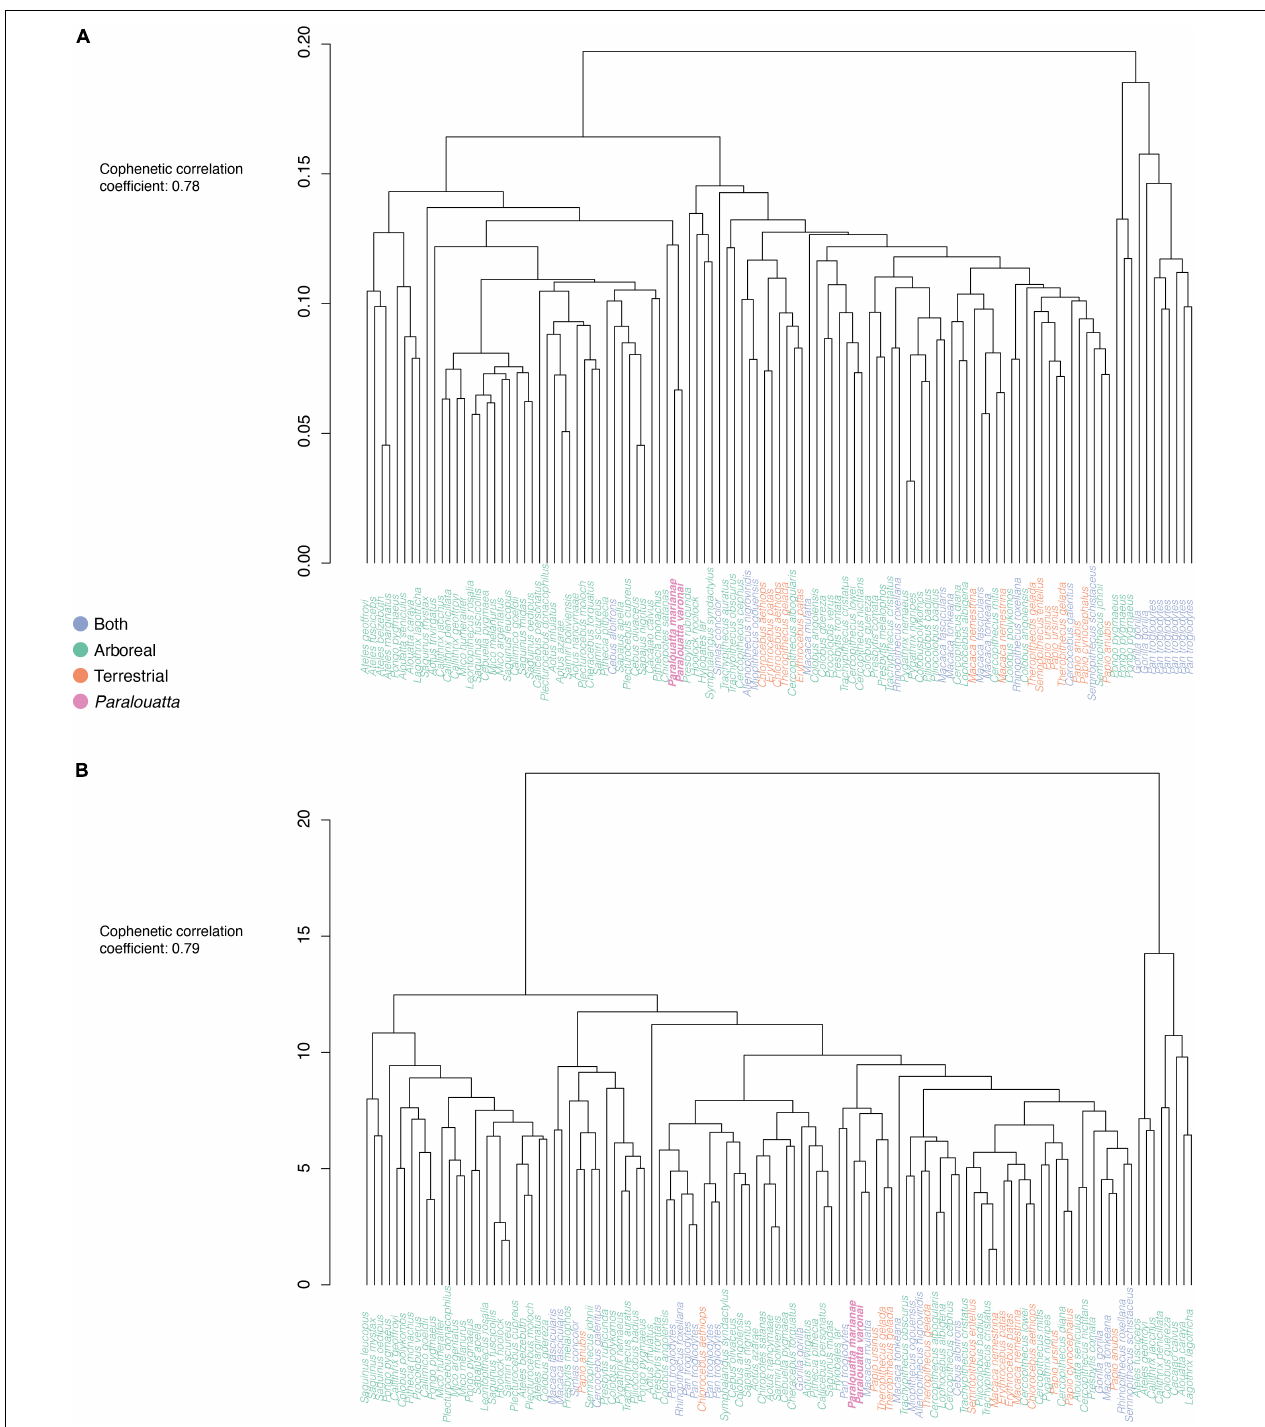
FIGURE 8 | UPGMA hierarchical clustering analyses of (A) shape and (B) biomechanical PCs. Fossils are in bold.